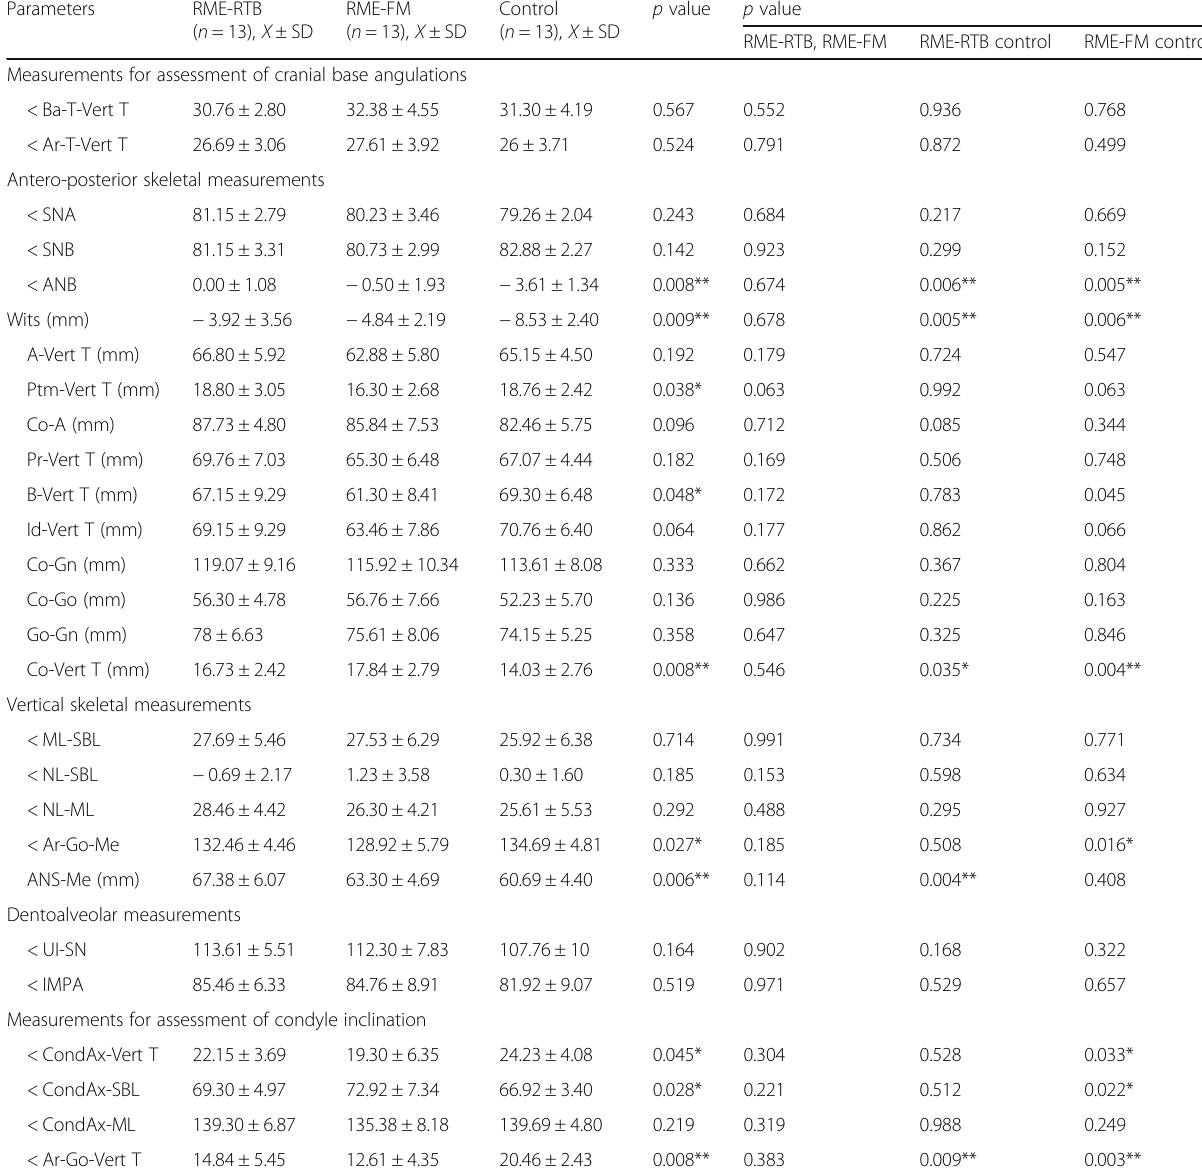
Table 4 Post-treatment comparison (T2) of the mean values of cephalometric analysis between the RME-RTB, RME-FM, and control groups